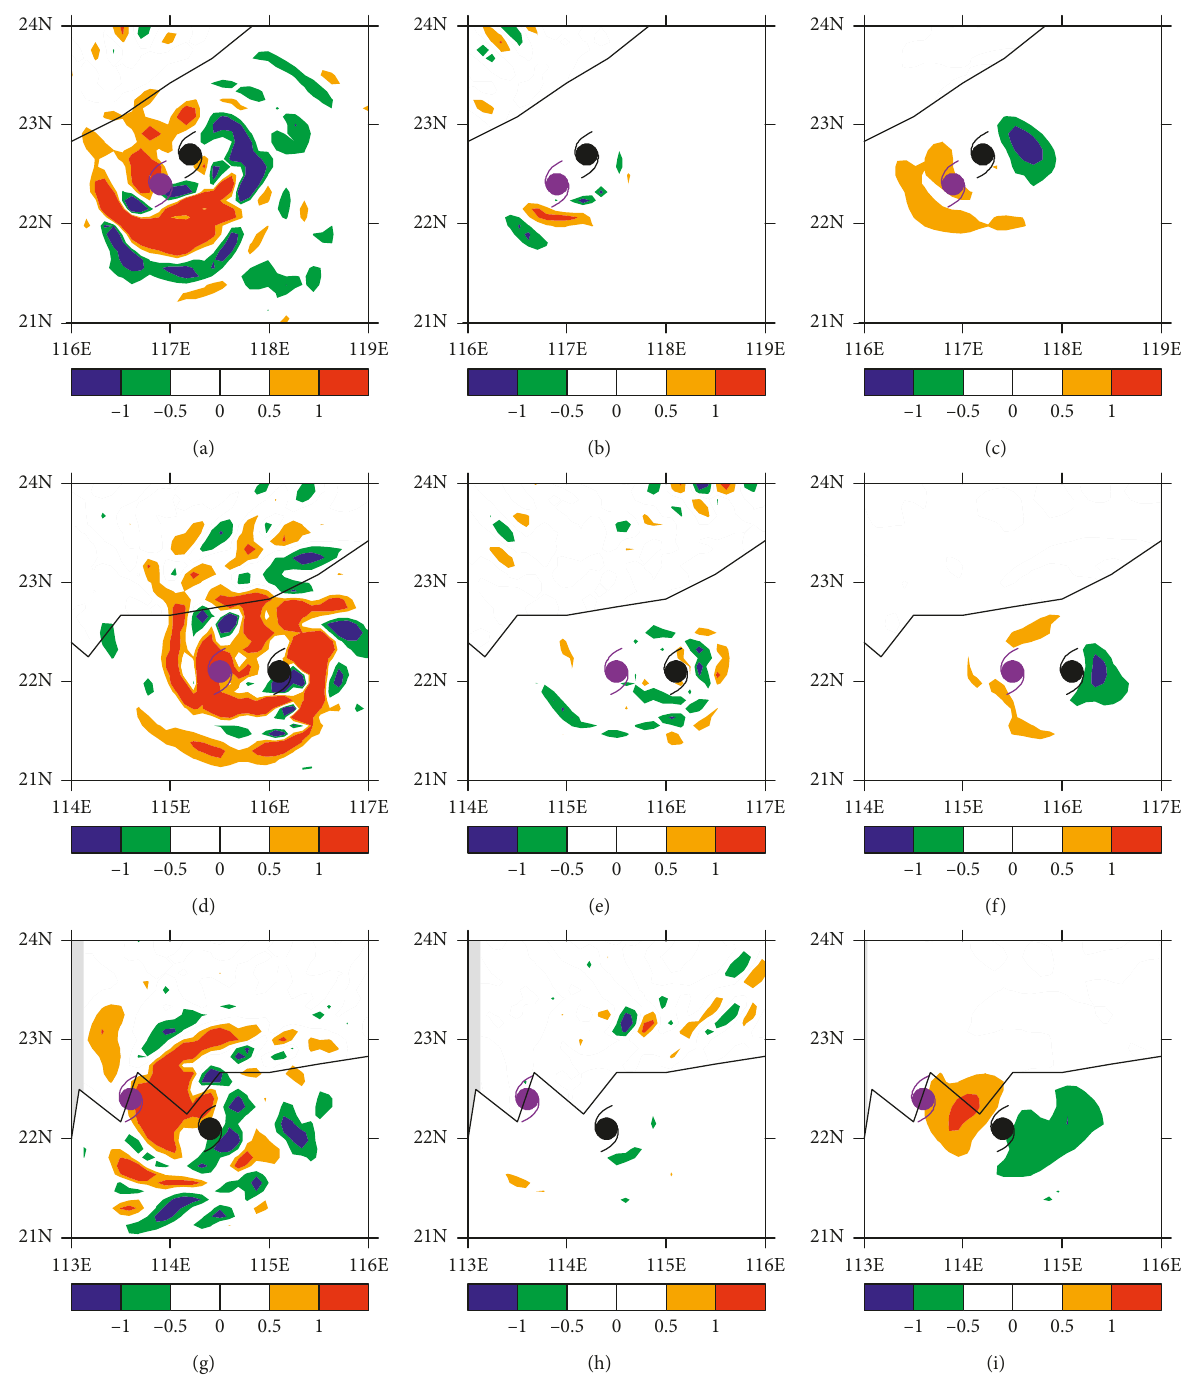
Figure 9: Vertical integrals of horizontal PV advection (HA, (a, d, g)), diabatic heating (DH (b, e, h)), and PV tendency (PVT (c, f, i)) in the NoB experiment at 0600 UTC 25 August (a–c), 0000 UTC 26 August (d–f), and 1800 UTC 26 August (g–i). Black dot represents the current Tembin’s position, and purple dot represents the next 6h Tembin’s position (unit: 10 − 6 K m 2 kg − 1 s − 2